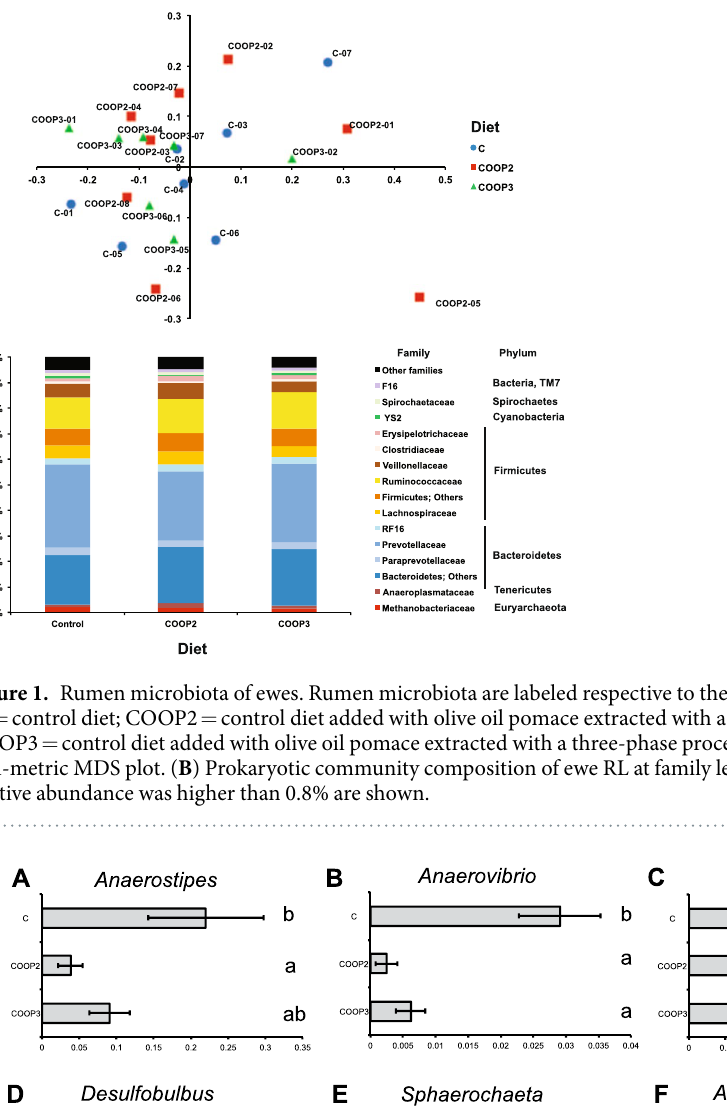
Desulfobulbus was positively related to DMAi13:0 (corr. coeff. + 0.4702; P = 0.02723). Considering the FAs involved in BH processes, Anaerovibrio was negatively correlated with α -LNA (corr. coeff. − 0.6096; P = 0.0025) and LA (corr. coeff. − 0.4795; P = 0.0239), while RFN20 genus was positively related to α -LNA (corr. coeff. + 0.5789; P = 0.0047) only. RA showed a negative correlation with Veillonellaceae (corr. coeff. − 0.4363; P = 0.0423) and a positive correlation with Coriobacteriaceae (corr. coeff. + 0.5425; P = 0.0090).